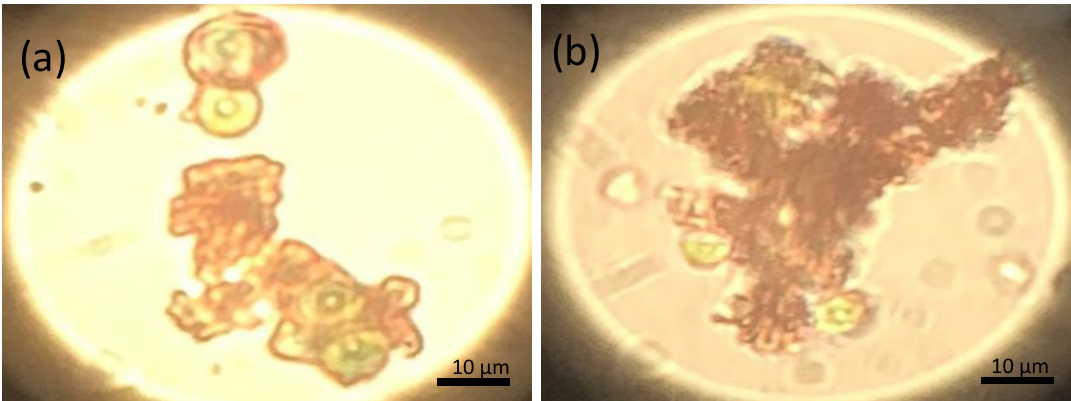
Figure 8. Trypan blue staining ( a , b ) on Chlorella vulgaris cells bound with magnetic particles (at pH 3.0) indicates the integrity of the cell membrane. Intact cells (viable) remained green, without the penetration of the trypan blue solution, while the broken cells appeared blue as stain diffused in the protoplasm.